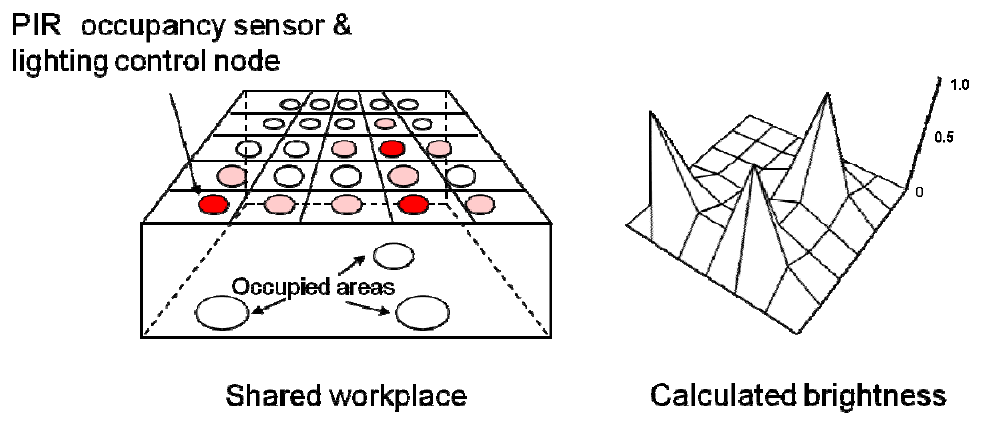
Figure 1. Decentralized sensor/actuator network system and calculated brightness of each node.